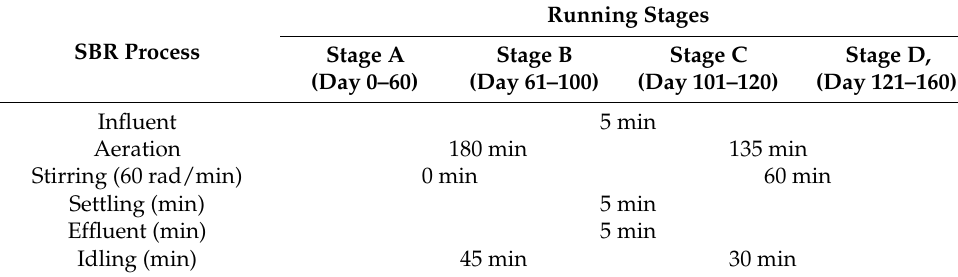
Table 1. SBR operating